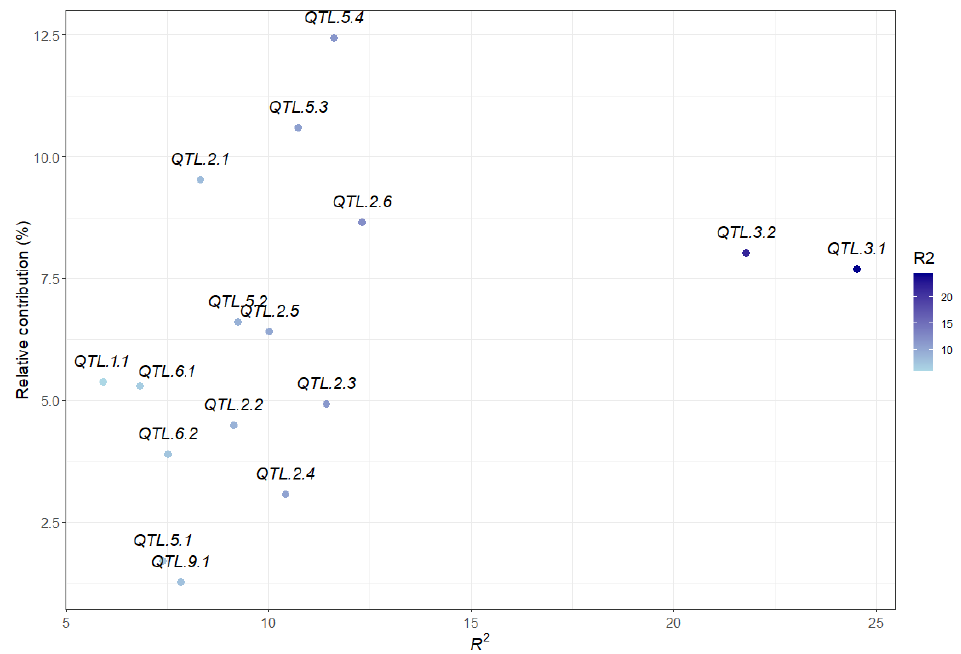
Figure 5. Relationship between the relative contributions (%) and mean R 2 of 16 quantitative trait loci (QTL).